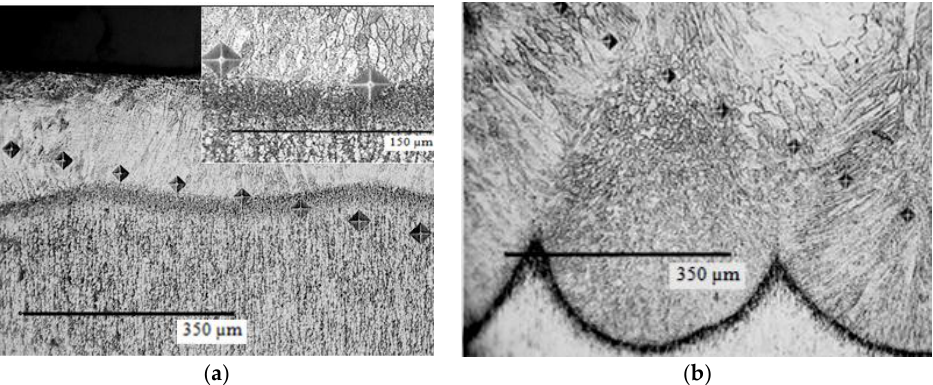
Figure 5. Cross-sectional microscopic details of the re-melted layer-substrate interface for different laser pulse powers. ( a ) Microstructure of the sample re-melted with 2200 W laser pulse power; and ( b ) microstructure of the sample re-melted with 2600 W laser pulse power.